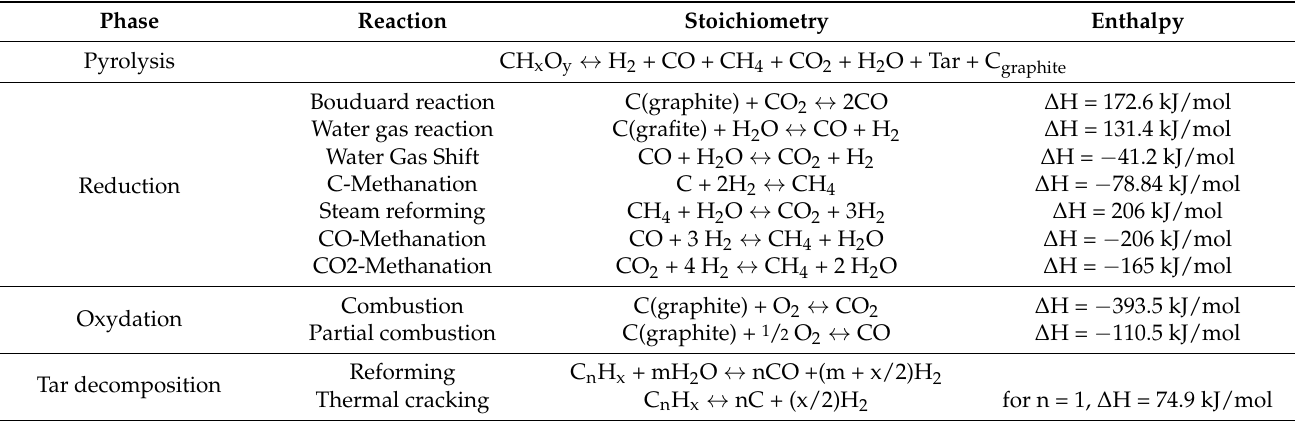
Table 5. Main reactions of